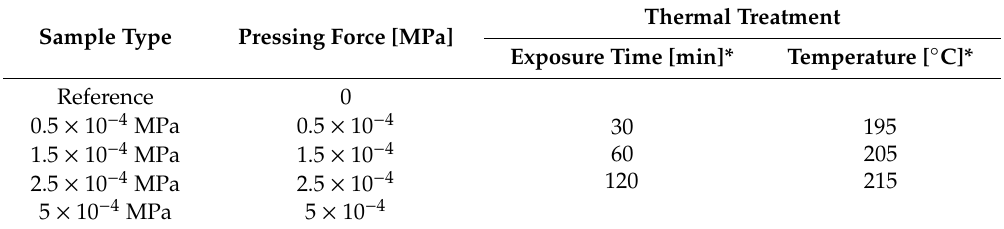
Table 1. Samples’ denomination according to synthesis parameters. 124